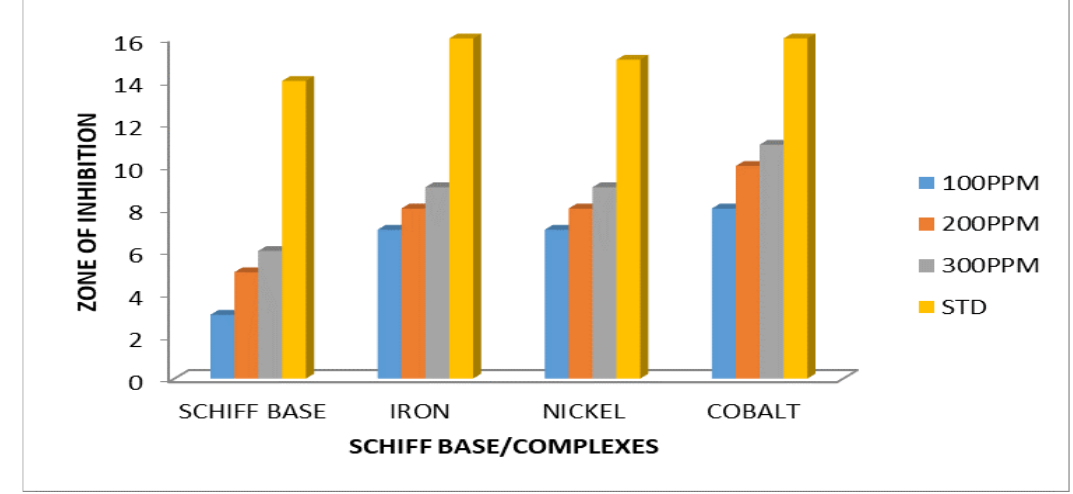
Figure 2. Sensitivity test for antibacterial activity of Schiff base and its metal (II) complexes against clinical isolate ( Escherichia coli ) using well diffusion method.